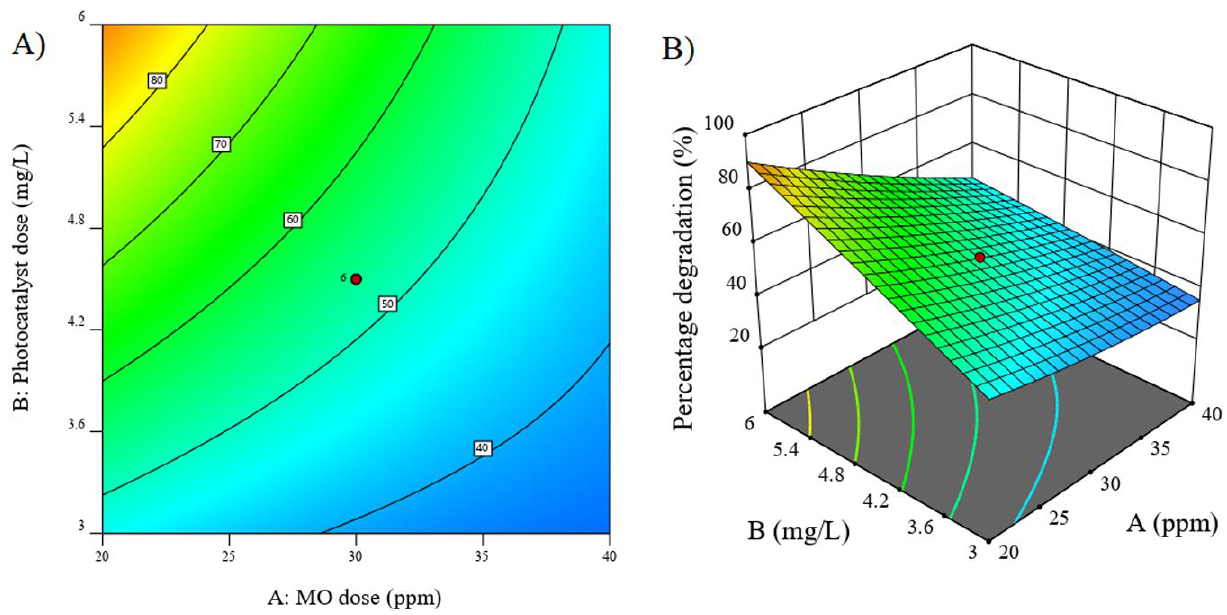
Figure 10. ( A ) Contour plot and ( B ) RSM-based surface plots for the interaction term of AB (MO dose × Photocatalyst dose).